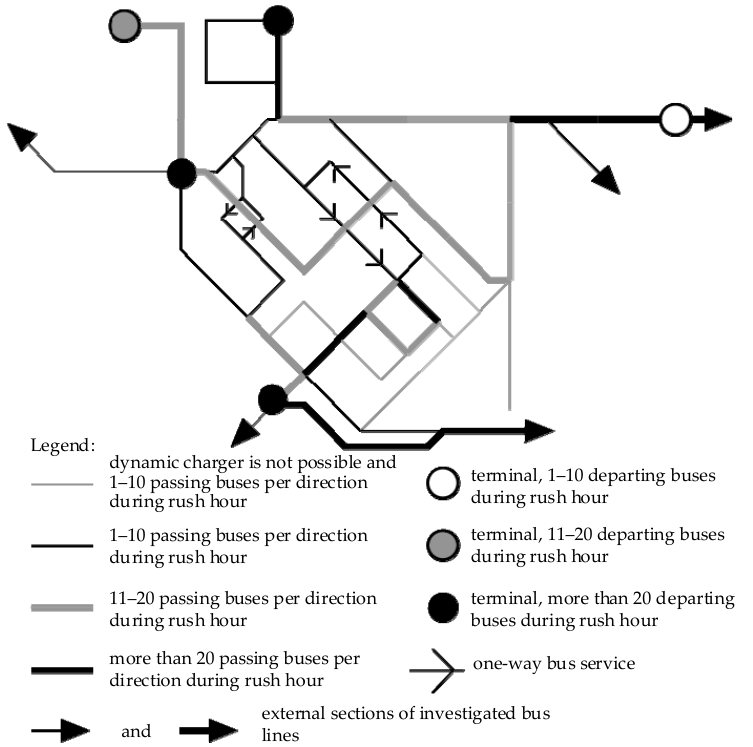
Figure 5. Structure of the public bus network of K ő bánya with the number of buses that run during the rush hour. the rush